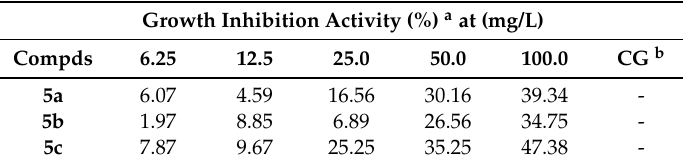
Table 2. The growth inhibitory activities to Mythimna separata Walker of 5a – c